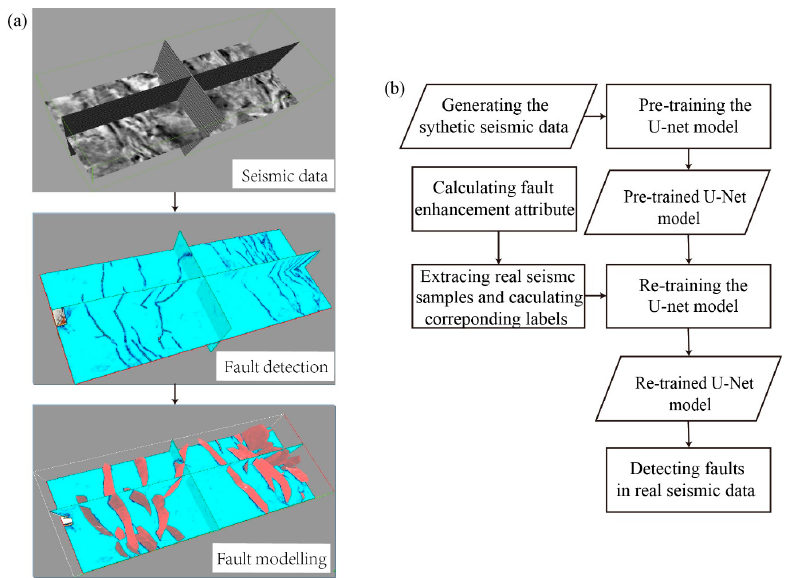
Figure 1. Schematic diagram of fault surface modelling ( a ) and block diagram of proposed methods ( b